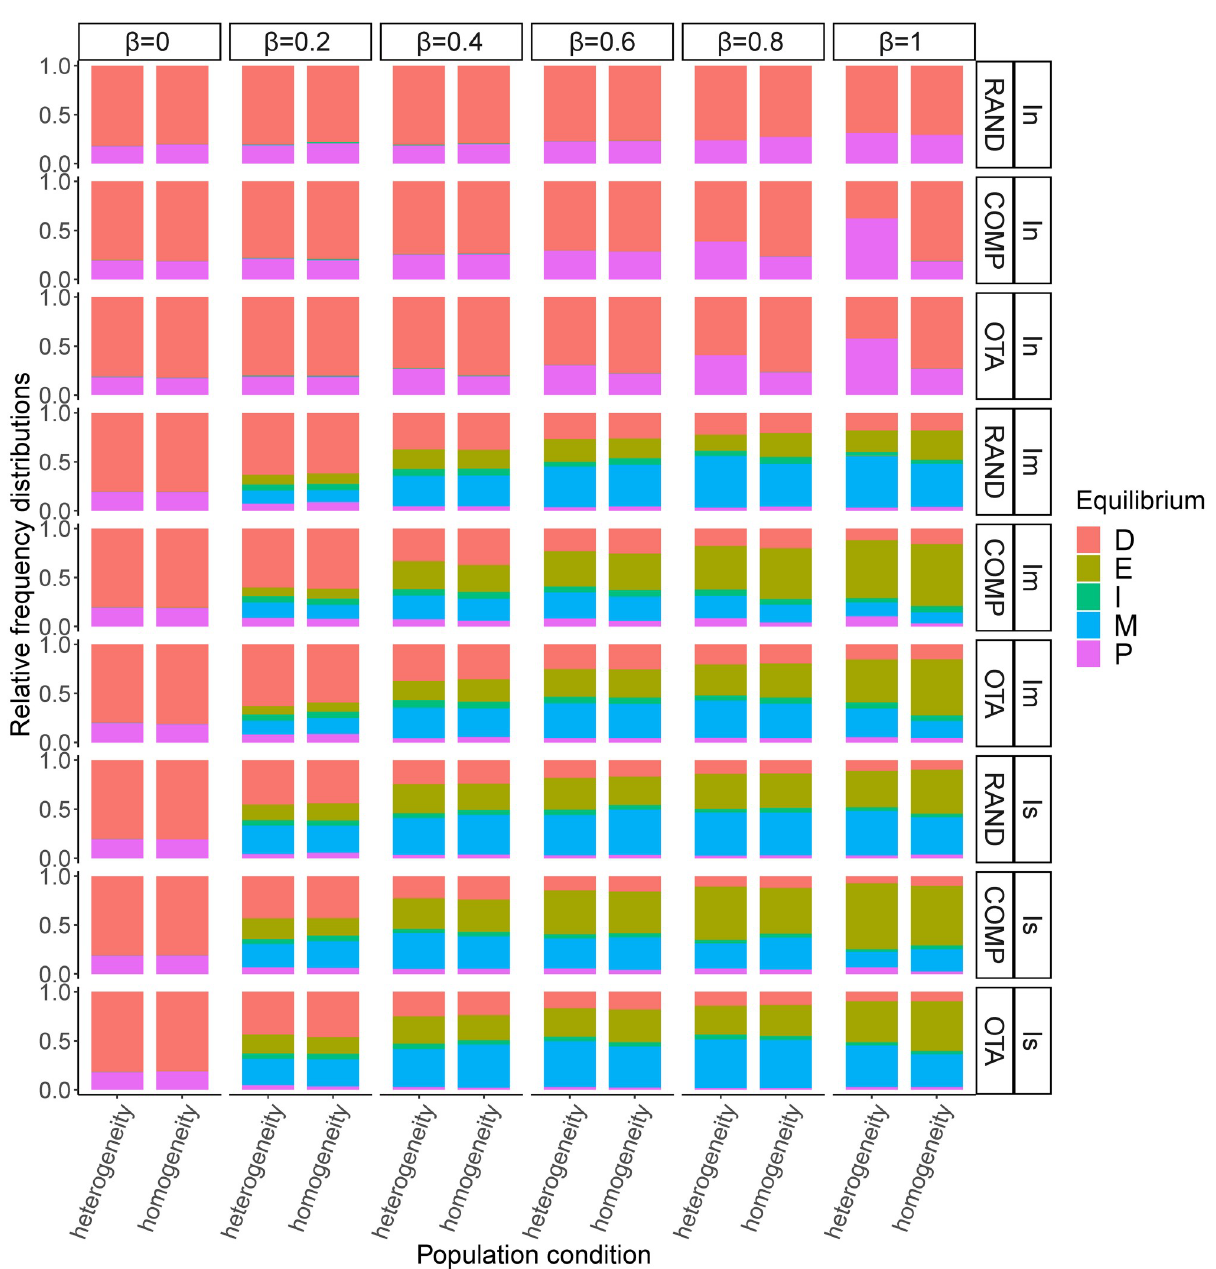
Fig 8. Relative frequencies of each equilibrium category when the frequency of opinions stabilises in the model under opinion-aggregating = neutral; I = moderate and I = strong; β = opinion value bias; value system types: OTA = one takes all, COMP = institutions. Institution influence: I n m s competition between two opinions, RAND = random. When institutional influence is intermediate, moderate consensus is more likely when the initial dispersion of values is high RAND , and extreme consensus is more likely under OTA and COMP . When institutional influence is strong, the probability of polarisation increases. In general, in the absence of institutional influence there is a high diversity of opinions at equilibrium.